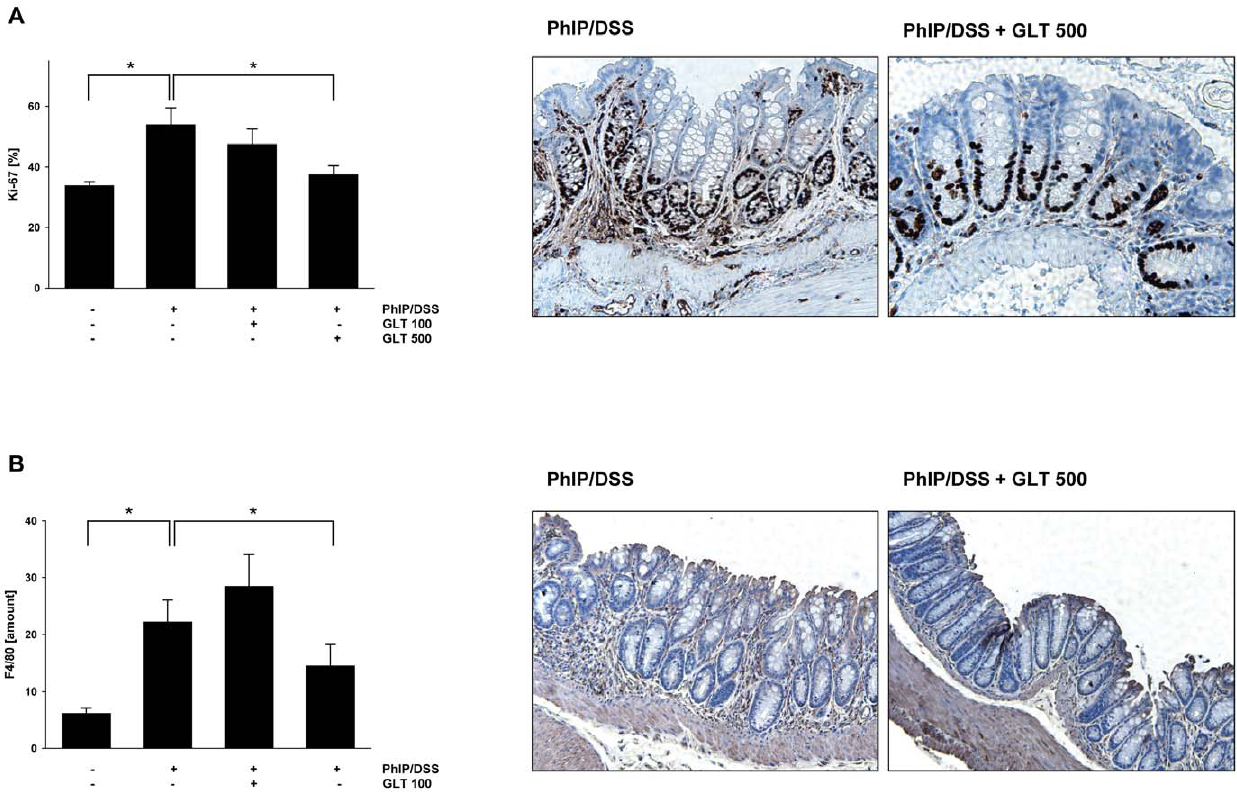
Figure 2. GLT down-regulates expression of Ki-67 and suppresses the amount of infiltrated macrophages. Immunohistochemistry and quantification of (A) Ki-67 and (B) F4/80 positive cells were performed as described in Materials and Methods . Results are means 6 SD (n=4–5 mice/ per group), *p , 0.05 by ANOVA. Representative pictures from (A) Ki-67 and (B) F4/80 staining in the PhIP/DSS group and the PhIP/DSS group treated with GLT (500 mg/kg of body weight) 3 times/week for 120